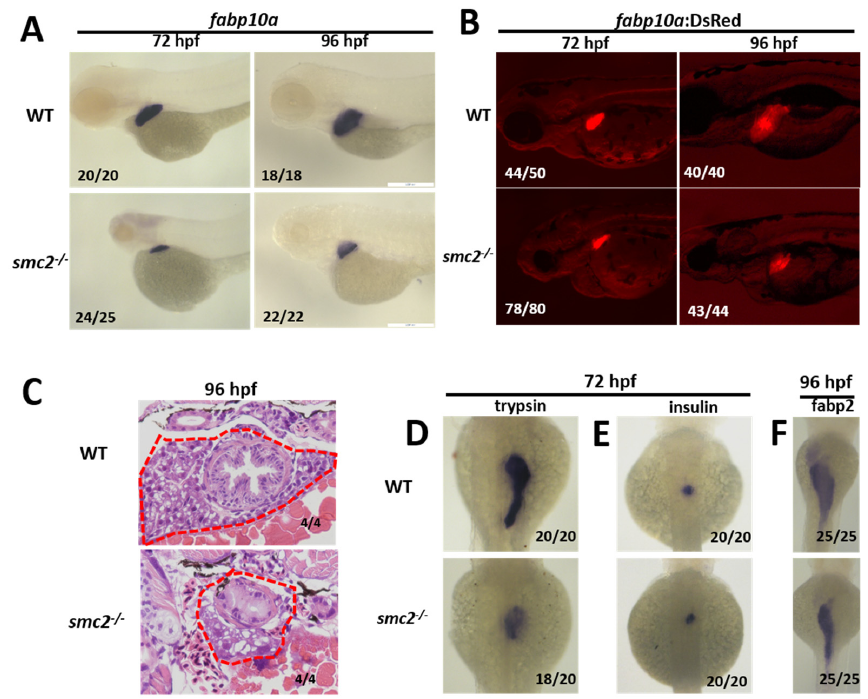
Figure 3 . Loss of SMC2 confers a small liver phenotype. ( A ) WT and SMC2 − / − mutant embryos were stained with RNA probes of fabp10a , a marker of hepatocytes at 72 and 96 hpf. ( B ) Liver size in SMC2 − / − mutants is smaller than that in the WT at 72 and 96 hpf, under the Tg (fabp10a:dsRed; ela3l:EGFP) transgenic background. ( C ) Livers from WT and SMC2 − / − mutants were analyzed with hematoxylin and eosin staining. ( D – F ) WISH using the exocrine pancreas marker trypsin ( D ), endocrine pancreas marker insulin ( E ), and intestinal maker fabp2 ( F ) as RNA